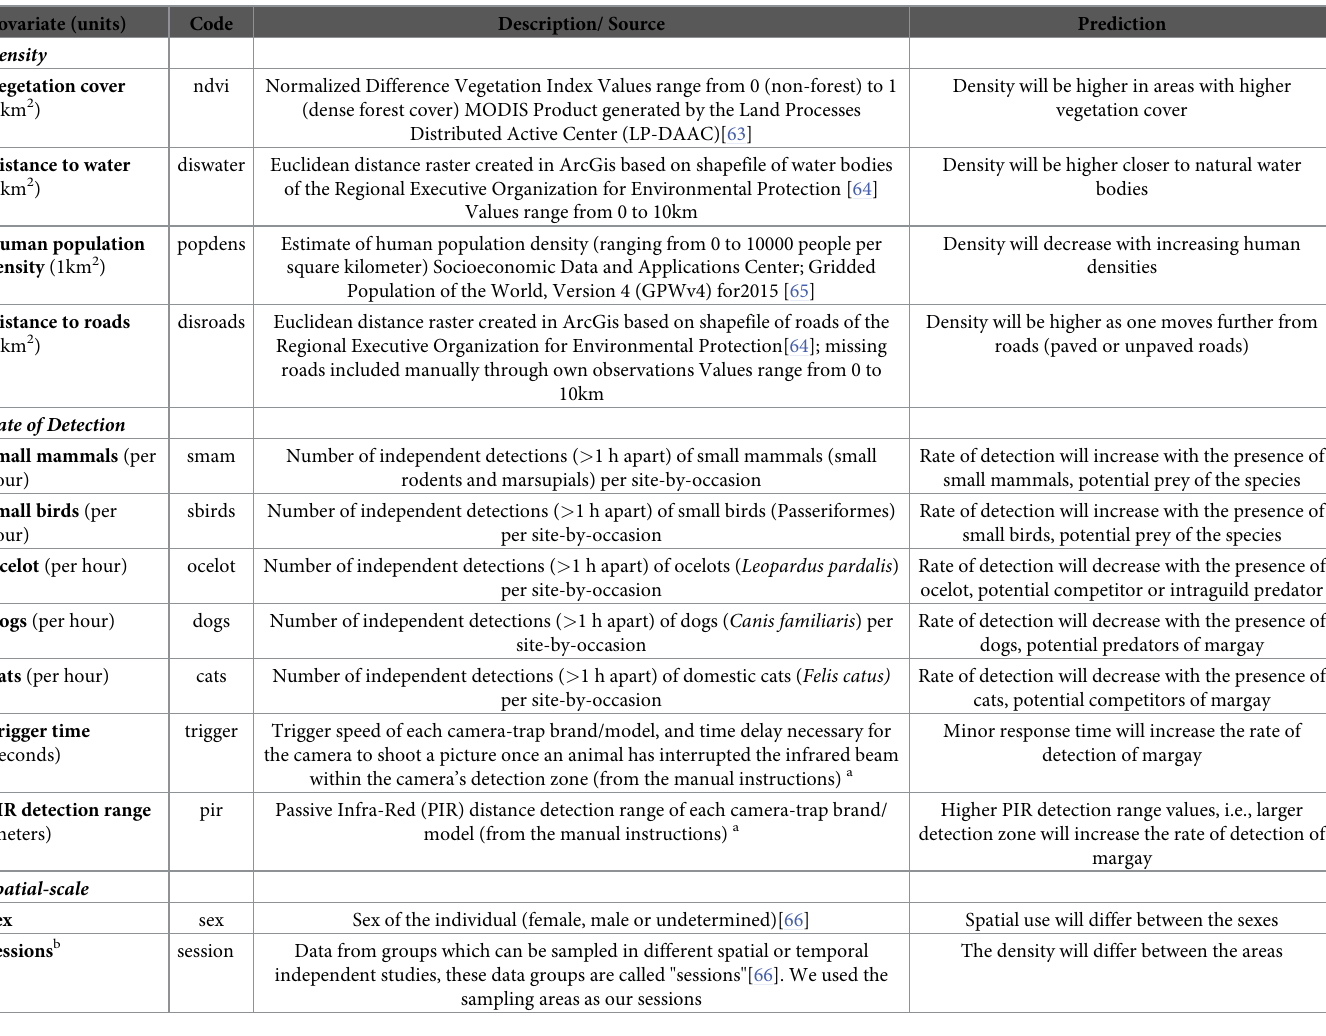
a we used the setting best camera-trap model to represent the camera-trap station (site). b we used this covariate for all parameters